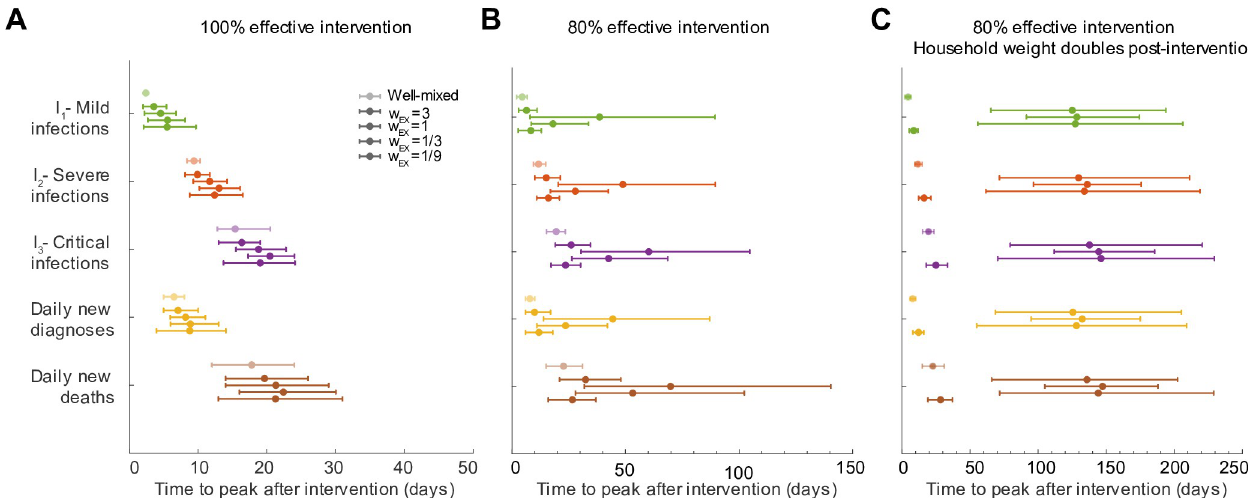
Fig 4. Time to epidemic peak after social distancing interventions depends on the relative roles of household and external transmission. A-C) Time to peak of different infection stages, measured as days post-intervention. A) Social distancing intervention with 100% efficacy at reducing external contacts (or all contacts in the case of a well-mixed network). B) Social distancing intervention with 80% efficacy. C) Social distancing intervention with 80% efficacy, and assuming that household weights double post-intervention ( w HH ! 2 w HH , due to increased time spent in the home). The first three quantities are peak prevalence levels (I 1 , I 2 , I 3 ), while the latter two are daily incidence values. We assume that cases are diagnosed only at the time of hospitalization. Daily incidence values were first smoothed using moving averages over a 7 day window centered on the date of interest. Bars represent 5th and 95th percentile. For each clinical stage included (each different color), the lighter-colored data point is the comparison to the well-mixed population, then the other points are for decreasing contributions of external connections and increasing role of household transmission.